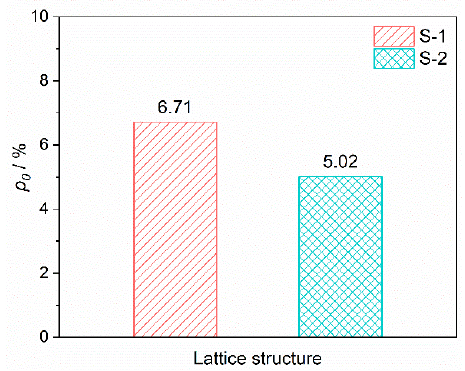
Figure 3. Relative density of the BWR lattices.